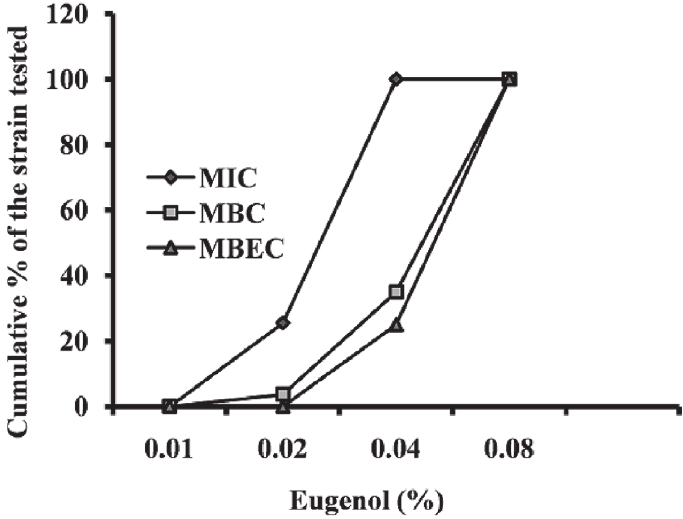
Fig 1. Cumulative minimum inhibitory concentration (MIC), minimum bactericidal concentration (MBC) and minimum biofilm eradication concentration (MBEC) of eugenol against Staphylococcus aureus expressed as a percentage of tested strains. MIC and MBC, n = 78; MBEC, n =